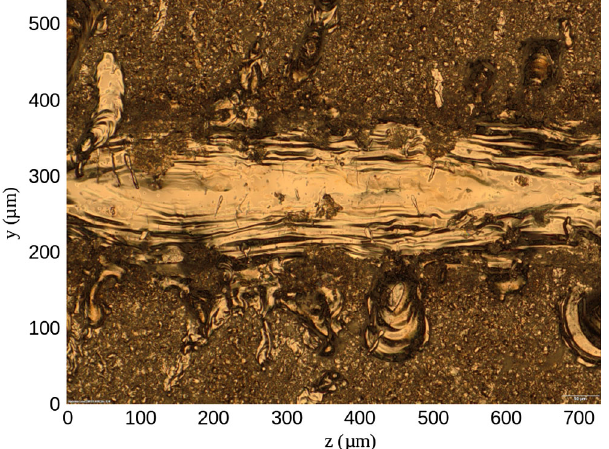
FIG. 30. Flattened image of the SN08, 200-mA, single-strike beam dump at location z 2 .